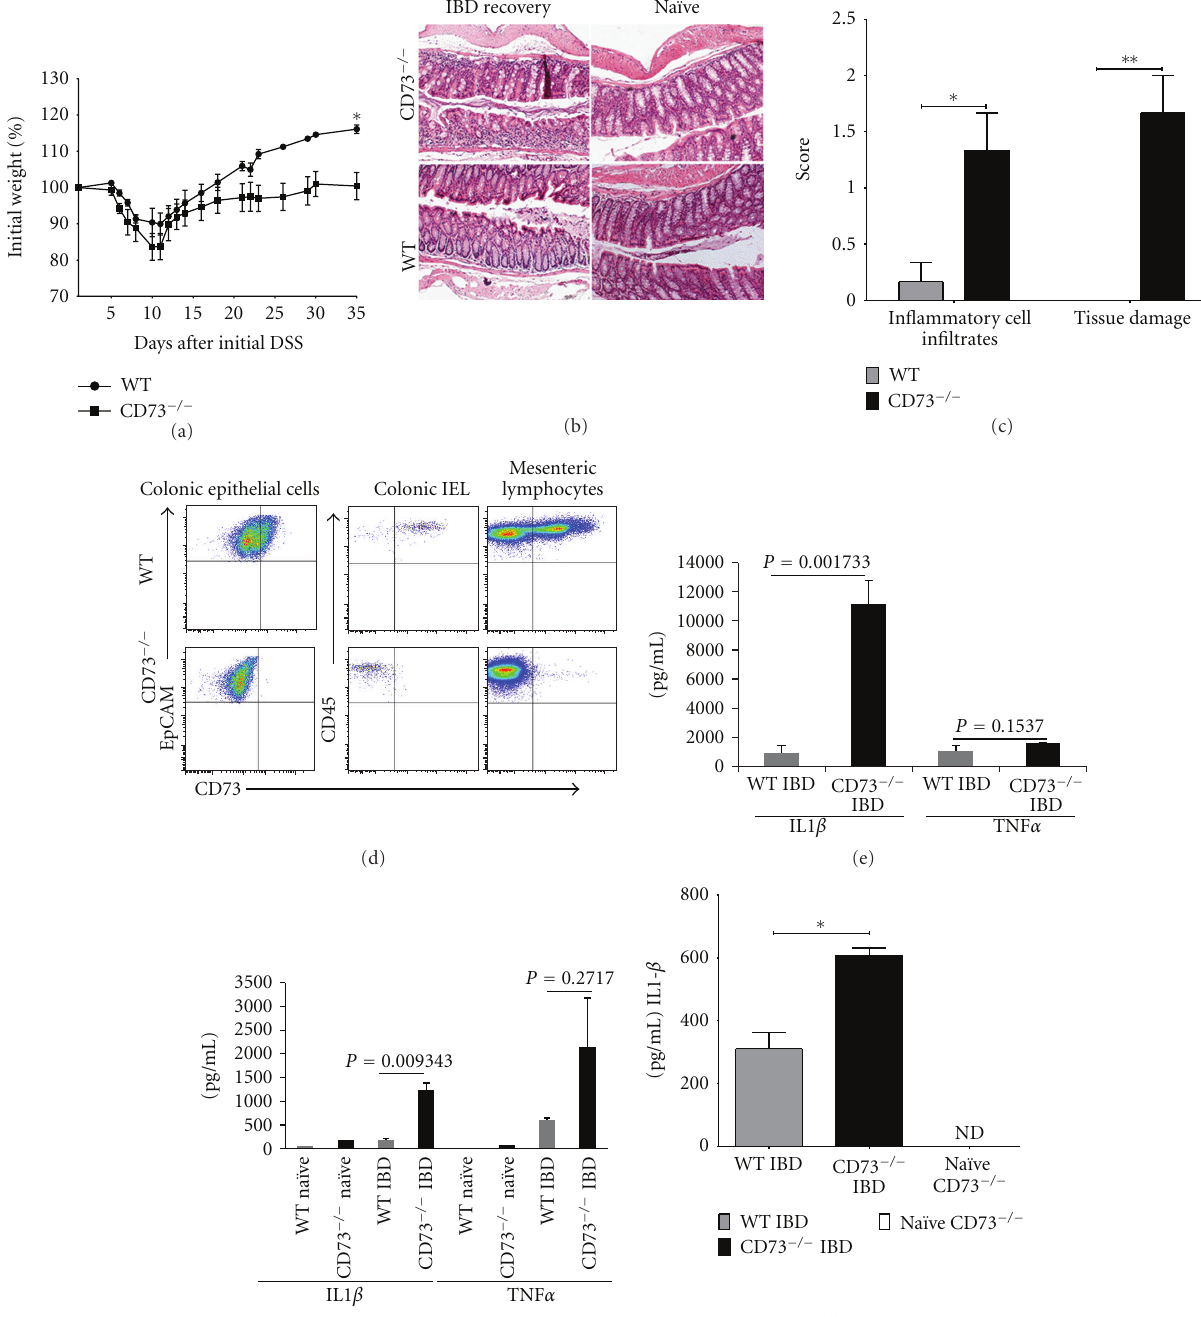
Figure 4: CD73 − / − mice exhibit ongoing inflammation and slower recovery from IBD compared to WT mice. (a) WT (circles) and CD73 − / − (squares) mice were given 3% DSS in drinking water and weighed daily for 35 days. DSS was removed at day 8 and replaced with drinking water. Results are represented as % of initial weight ( ± SEM, ∗ P < 0 . 05, one of two representative experiments). (b) H&E staining of colons from CD73 − / − (top) and WT (bottom) mice taken on day 35 (left) compared to na¨ıve (right) mice. (c) Mean ( ± SEM, ∗ P < 0 . 05, ∗∗ P < 0 . 01) colonic inflammatory score is displayed ( n = 5 mice). The scoring scale is comprised of two components: (i) inflammatory cell infiltrate (focus of inflammatory cells in the lamina propria = 1, confluence of inflammatory cells = 2, and transmural extension of the infiltrates = 3); (ii) tissue damage (discrete lymphoepithelial lesions = 1, mucosal erosion = 2, and extensive mucosal damage and extension through deeper structures of the bowel wall = 3). (d) FACS analysis of CD73 expression on colonic epithelial cells from na¨ıve WT (top left panel, 28%) and CD73 − / − (bottom left panel, 0%) mice. Colonic epithelial cells identified with CD326/EpCam. Colonic IEL’s identified with CD45 (middle panels, WT 87% CD73 + ). Mesenteric lymph nodes shown as a positive control (right panels, WT 39% CD73 + ). (e) IL-1 β and TNF α production in colon preparation isolated from WT and CD73 − / − mice on day three of DSS treatment and (f) day eight of DSS treatment. (g) Colons isolated from WT and CD73 − / − mice on day 22 after removal of DSS were cultured (in medium alone) for 24 hours and supernatant analyzed by Bio-Plex for IL-1 β . Results (mean ± SEM, ∗ P < 0 . 05, representative of one experiment, n = 3 mice per group) are presented as pg/mL IL-1 β